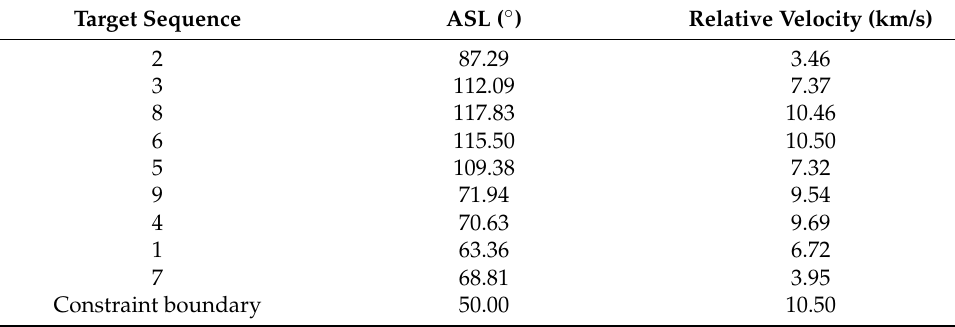
Table 3. Constraint values of each inspection task of example